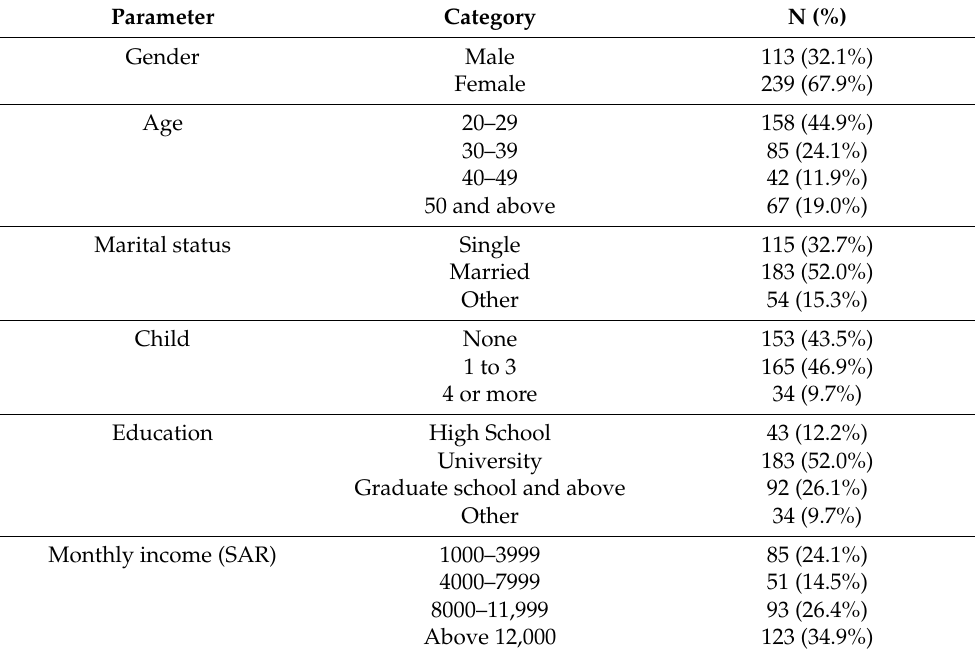
Table 1. Demographic characteristics of the